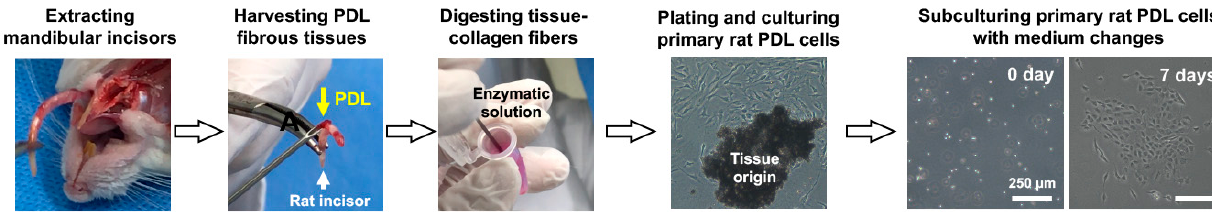
Figure 1. Rat periodontal ligament (PDL) tissues are harvested from the incisors of mandibles, and primary cells growing from the tissue origin are cultured up to the passage number 3. A yellow arrow indicates PDL tissue on the incisor surface and a white arrow points the extracted incisor from the rat mandible.